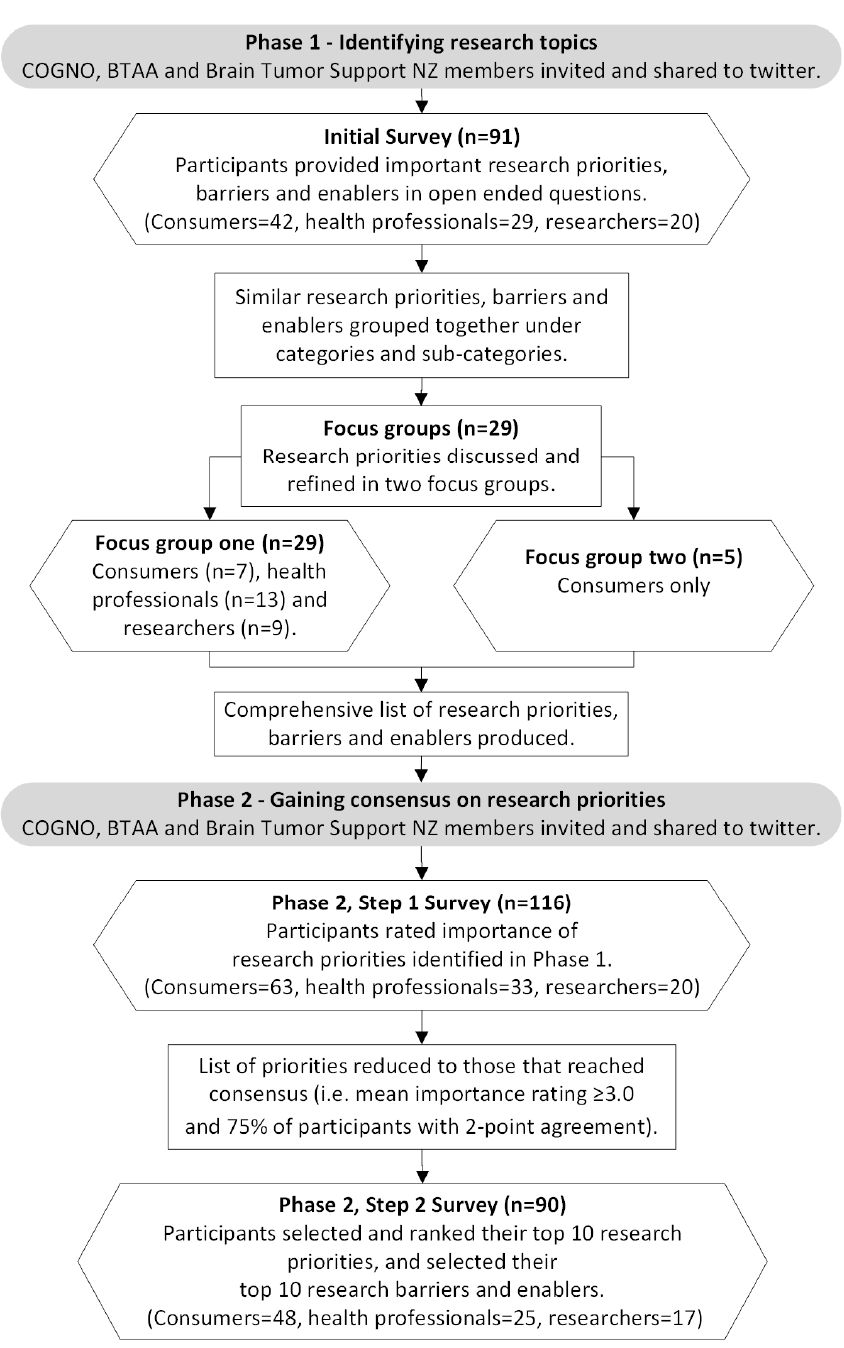
Figure 1. Overview of the research process. Brain Tumour Alliance Australia (BTAA), Cooperative Trials Group for Neuro-Oncology (COGNO), New Zealand (NZ). Trials Group for Neuro-Oncology (COGNO), New Zealand